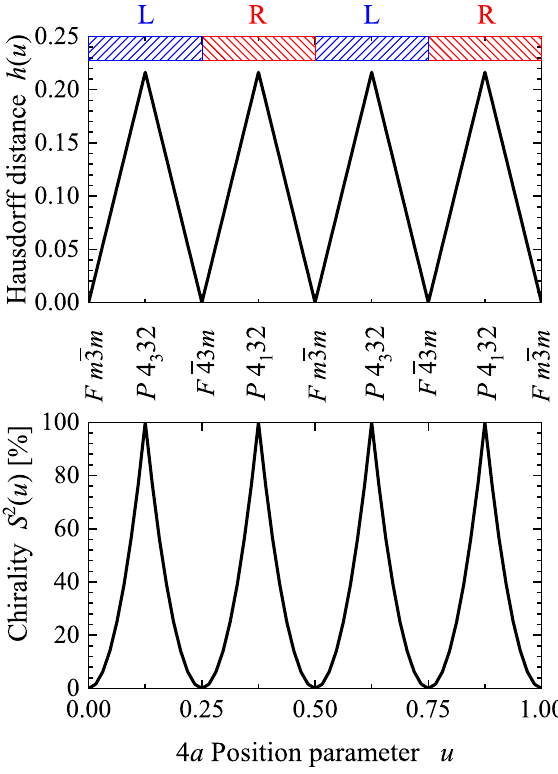
Figure 4. Hausdorff distance h ( u ) and continuous chirality measure S 2 ( u ) in a chiral cubic compound based on space group 198 with a single 4a Wyckoff position occupied. Shown are the dependencies of h ( u ) and S 2 ( u ) on the position parameter u of the Wyckoff position 4 a . The character (R and L) of structures in space group 198 is adopted from the handedness of the closest chiral space group 213 or